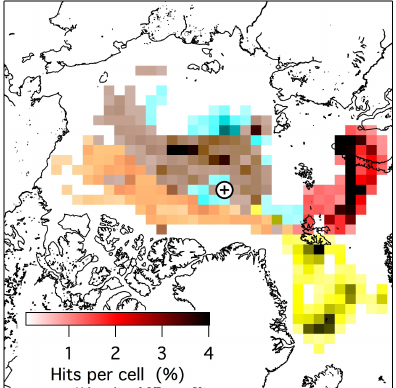
Figure 4. Regional distribution of five clusters of back trajectories with hourly DMS values of all Oden cruises. Cluster 2 is red; clus- ter 3 is yellow; cluster 7 is mocha; cluster 8 is Cyan; longitudinal cluster (LC) is in grey. The color saturation indicates the number of trajectory hits per geocell in percent. Only geocells with at least 25 trajectory hits are shown. The plus symbol indicates the North